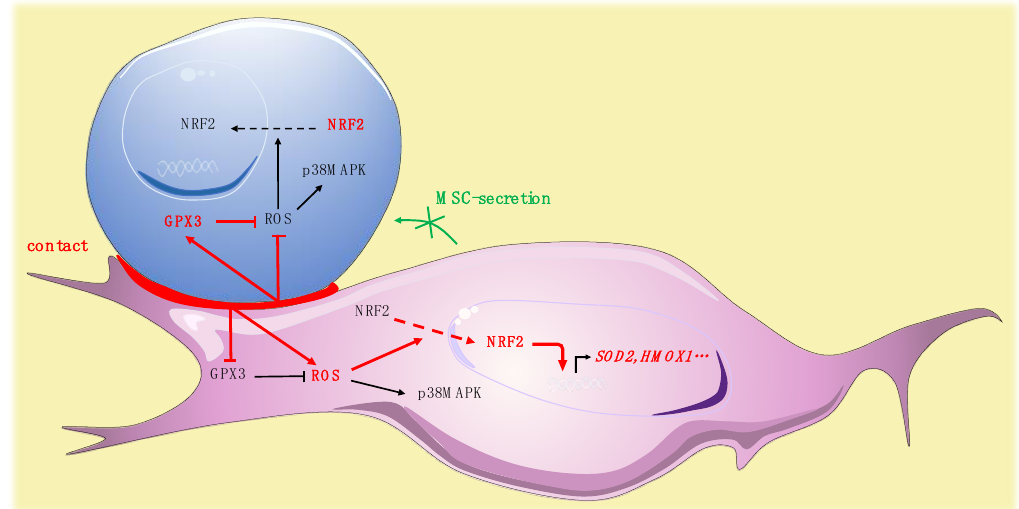
Figure 7. Pivotal role for Gpx-3 in ROS regulation and oxidative metabolism in leukemic niche (leukemic cell in ( blue ), MSC in ( purple )).